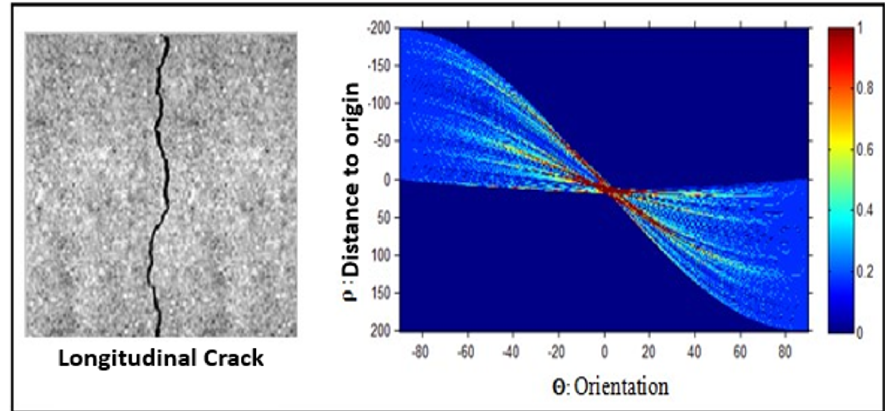
Figure 10. Hough Transformation for an example of crack.